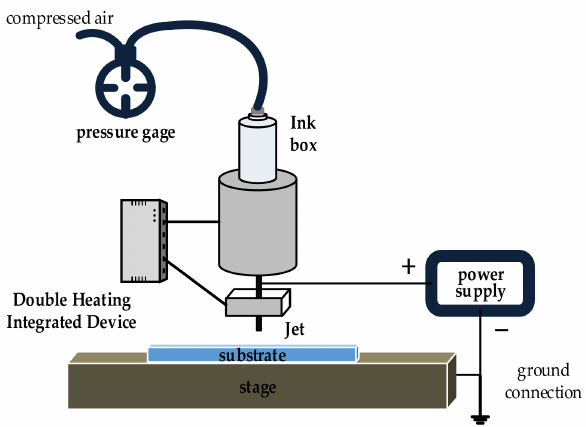
Figure 1. A schematic diagram of the electrohydrodynamic (EHD)-assisted direct printing system.